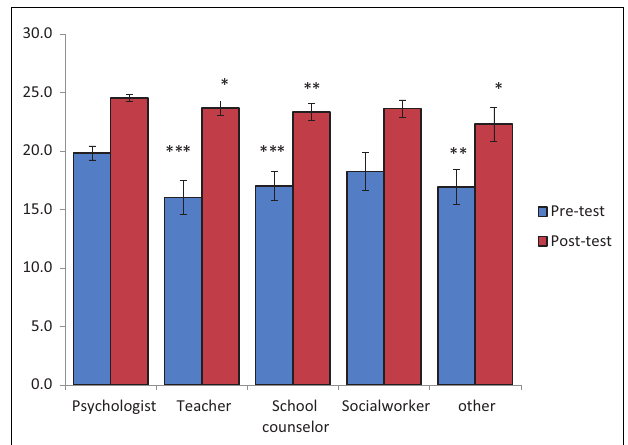
FIGURE 2 | Before and after performance by professions (psychologist, teacher, school counselor, social worker, and other) . *** p -value <0.001; ** p -value <0.01; * p- value <0.05. t -tests for unequal variance/when data were < 30 observation in any group was used